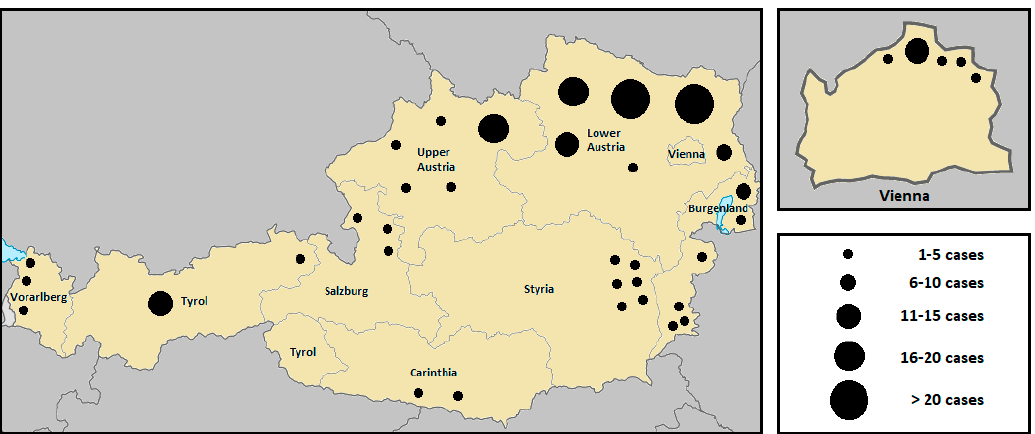
Figure 2. Summative geographic distribution of human tularemia cases in the various Austrian provinces from 1990 to 2019. The size of the dots corresponds to the number of humans infected with F. tularensis during a five year period [82].